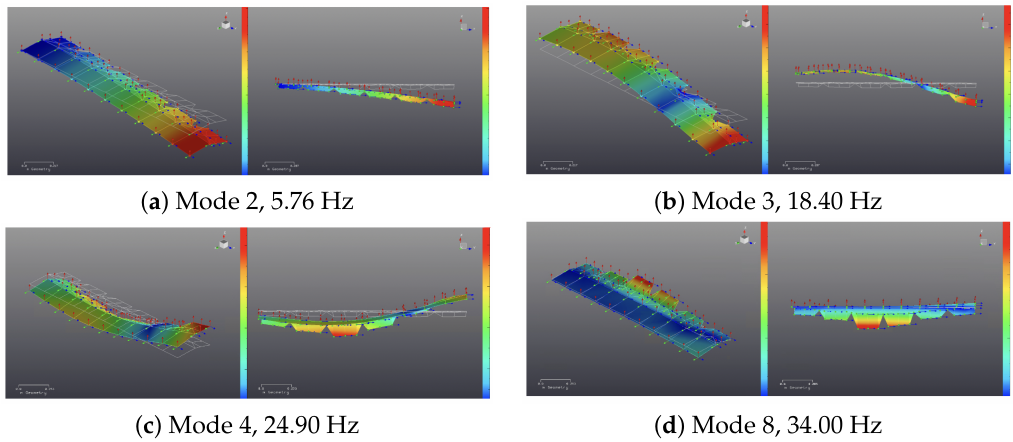
Figure 12. Four selected modes of the SmartX-Alpha wing